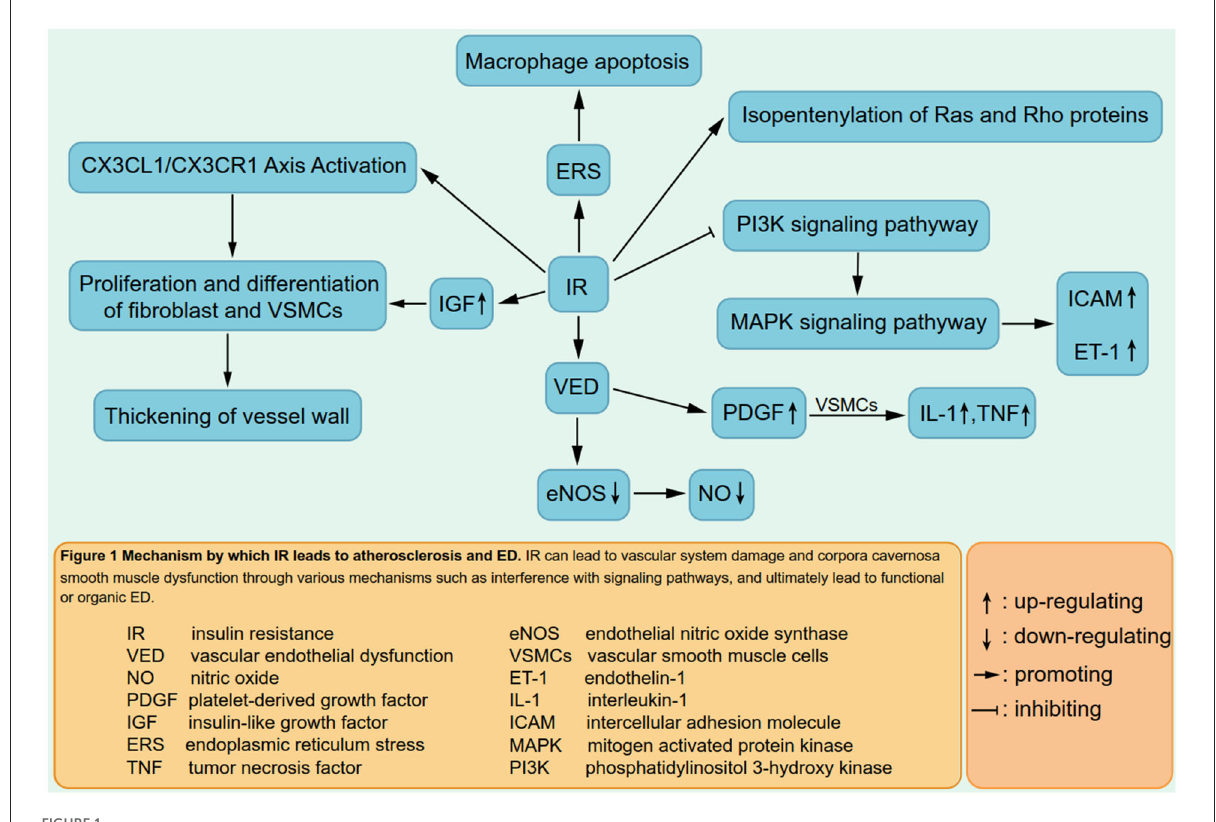
FIGURE1 Mechanism by which IR leads to atherosclerosis and ED. IR can lead to vascular system demage and corpora cavernosa smooth muscle dysfunction through various mechanisms such as interference with signaling pathways, and ultimately lead to functional or organic ED.